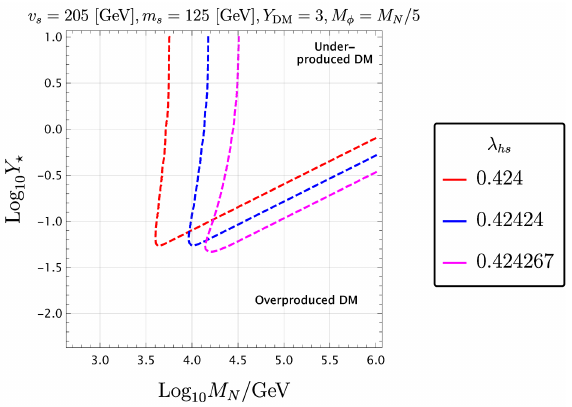
Figure 8 . DM production in the fermionic portal model. We fix M DM = M N / 5 , and Y DM = 3 . Only the co-annihilation regime where | M φ − M χ | . M φ / 20 appears to be viable and shown by dashed